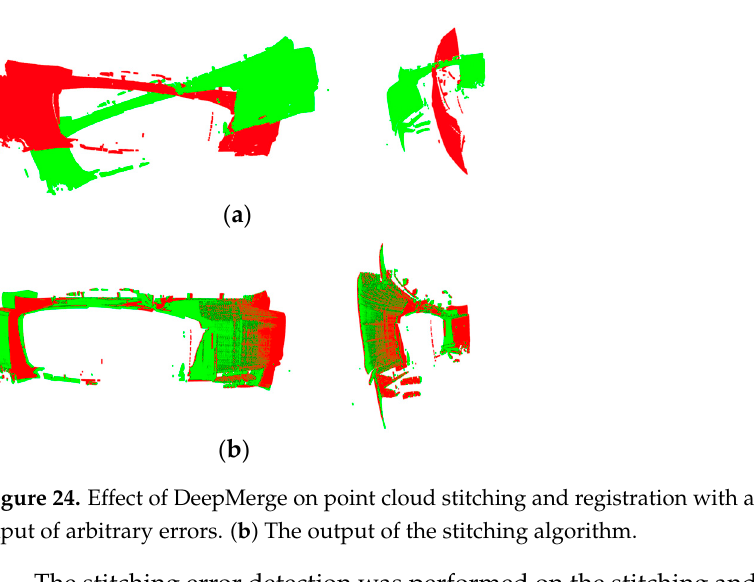
The input of arbitrary errors. ( b ) The output of the stitching algorithm. input of arbitrary errors. ( b ) The output of the stitching algorithm.